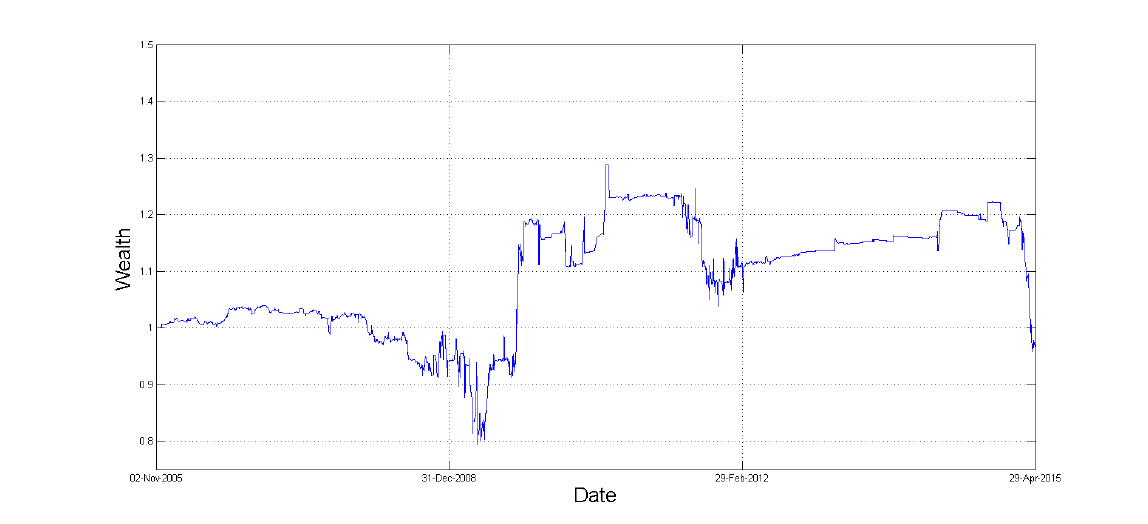
Figure 7. Ex-post wealth on Russian bonds after second phase